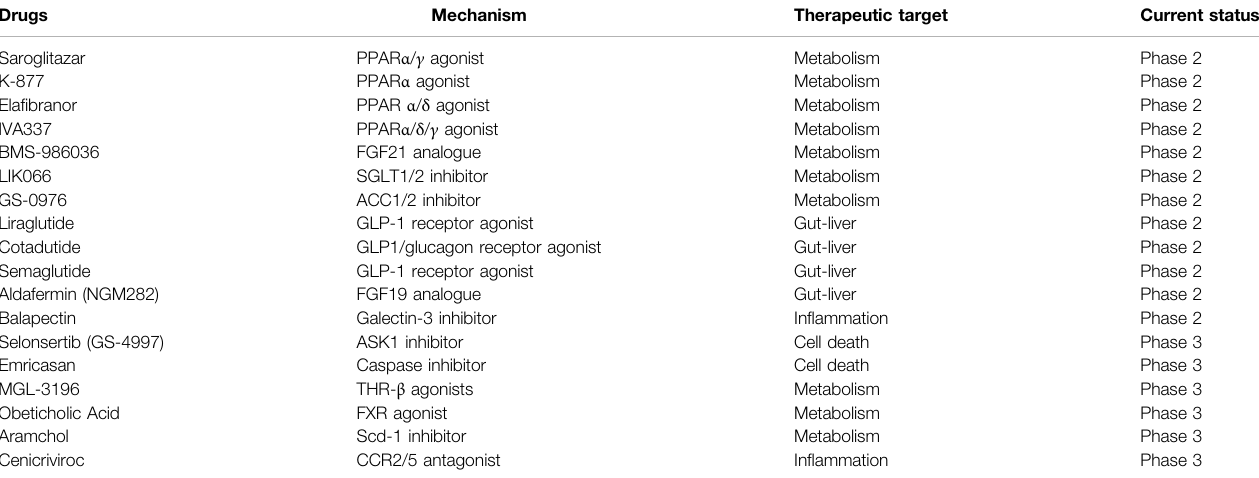
TABLE 1 | New pharmacotherapeutics with anti fi brotic effects currently in clinical trial.